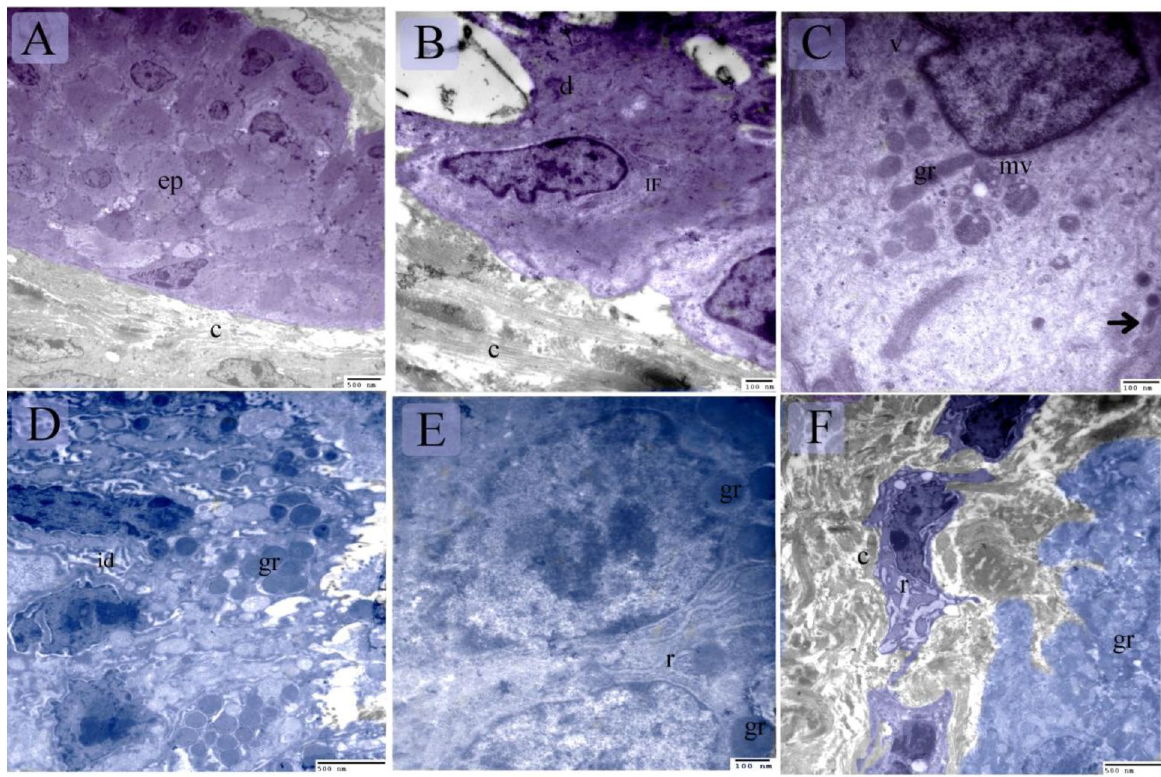
Dendritic cells had vesicles (V), multivesicular bodies (mv), dense granules (gr), rod-shaped granule (arrow). ( D , E ) Esophageal gland contained mucous granules (gr), RER (r), interdigitation (id). ( F ) Fibroblast (dark blue) rich in dilated RER (r). Collagen (c), granules of the mucous gland